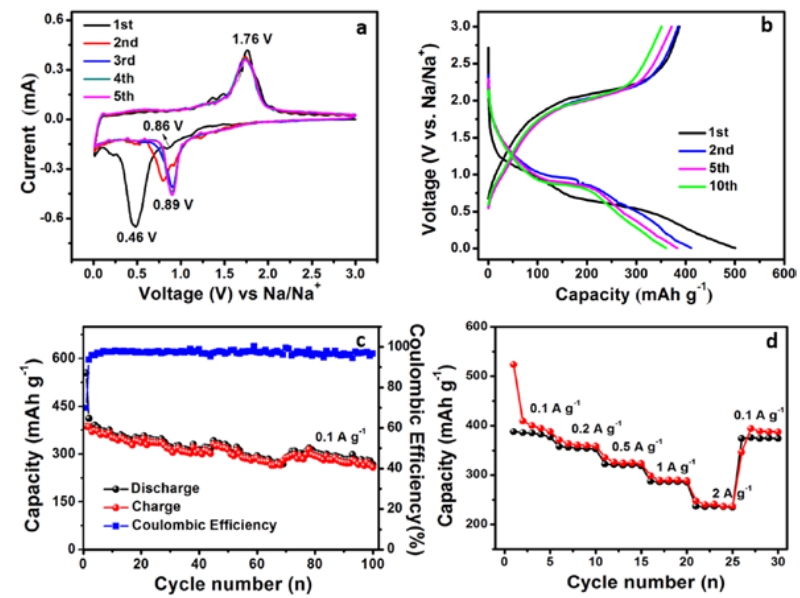
Figure 6. Cyclic voltammograms ( a ), galvanostatic discharge/charge profiles ( b ), cycling performances ( c ) and ( d ) rate performances of the TiO 2 nanobelt@Co 9 S 8 composites for SIBs.